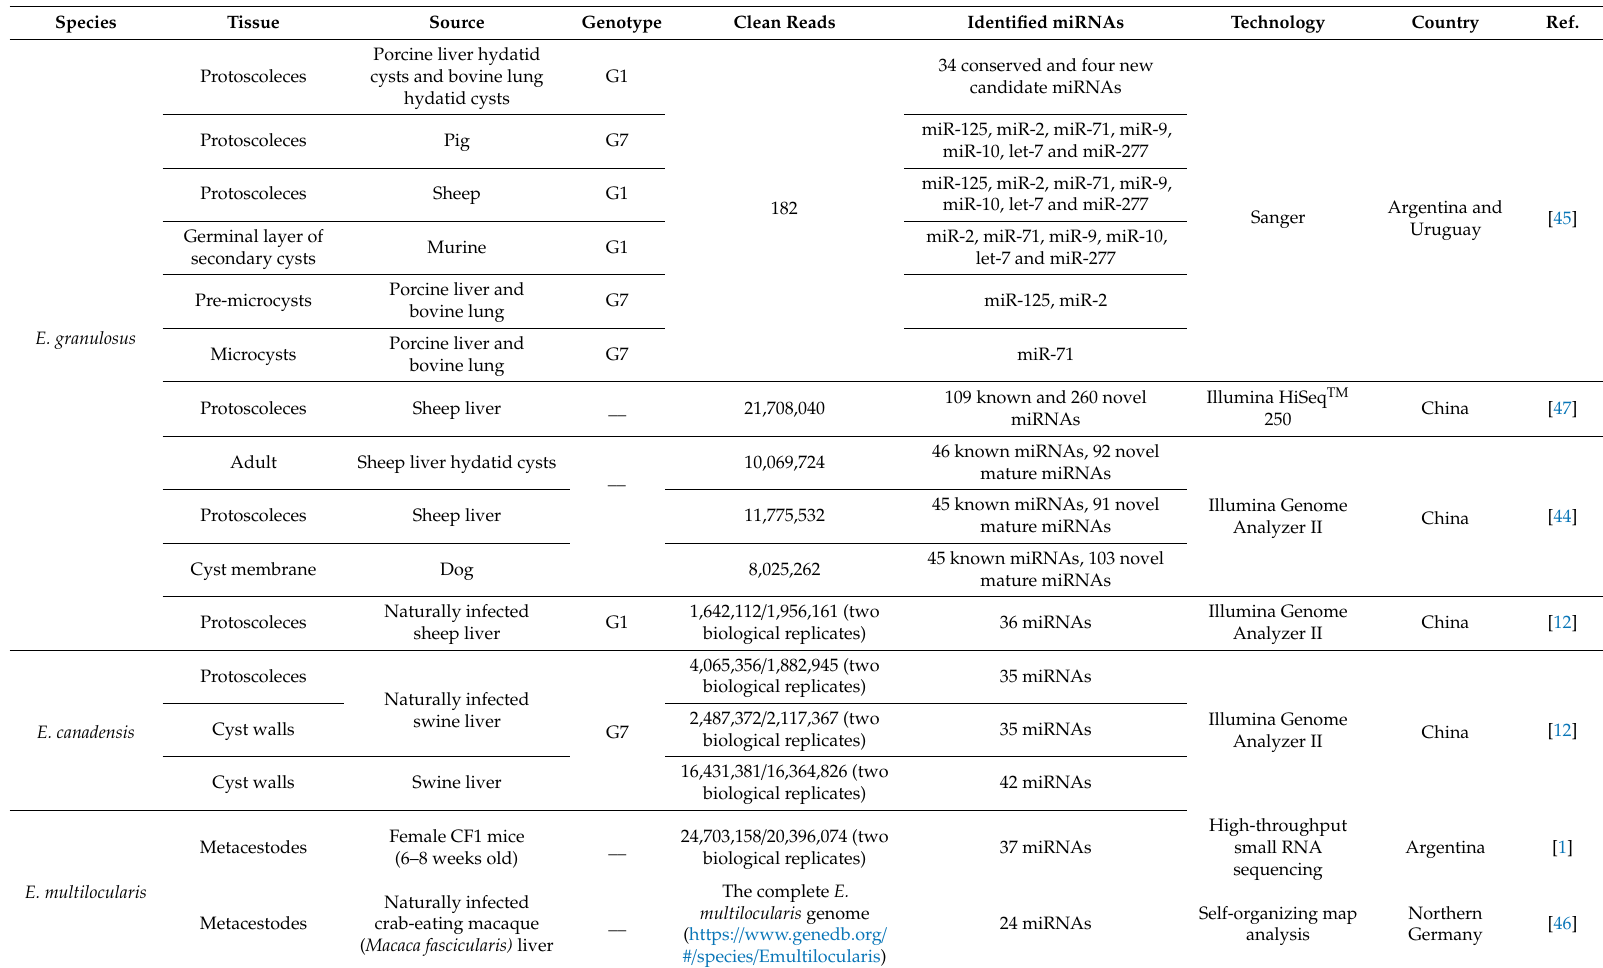
Table 1. Widespread Expression of microRNAs (miRNAs) in Echinococcus spp. According to Transcriptome Analysis.